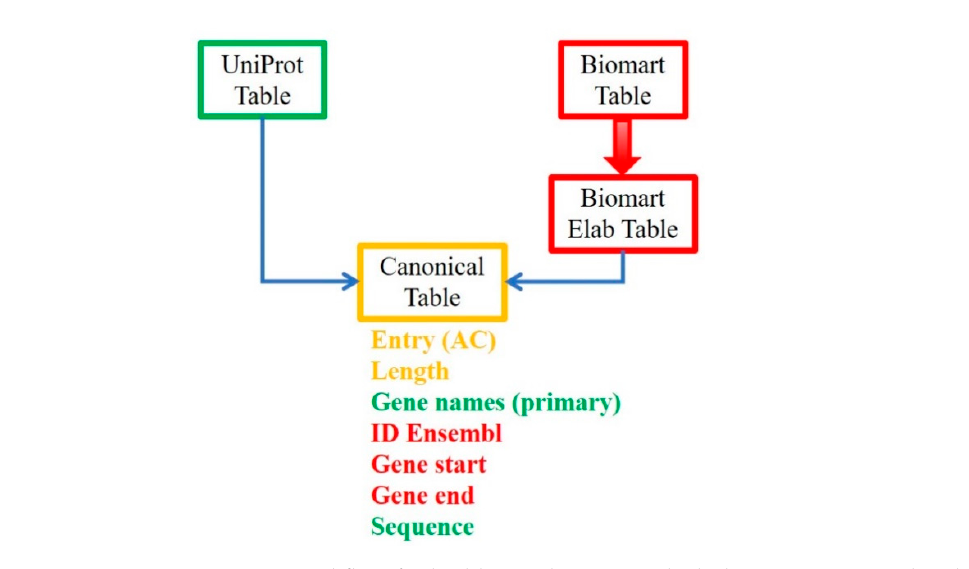
Figure 1. Workflow for building a dataset in which the proteins are ordered by their position on the chromosome. Protein data extracted from the UniProt database are matched with genetic data extracted from the Ensembl database and retrieved by Biomart. In green are the data collected from UniProt, in red the data obtained from Biomart search, and in yellow the data identical in both collections and used to merge the tables.